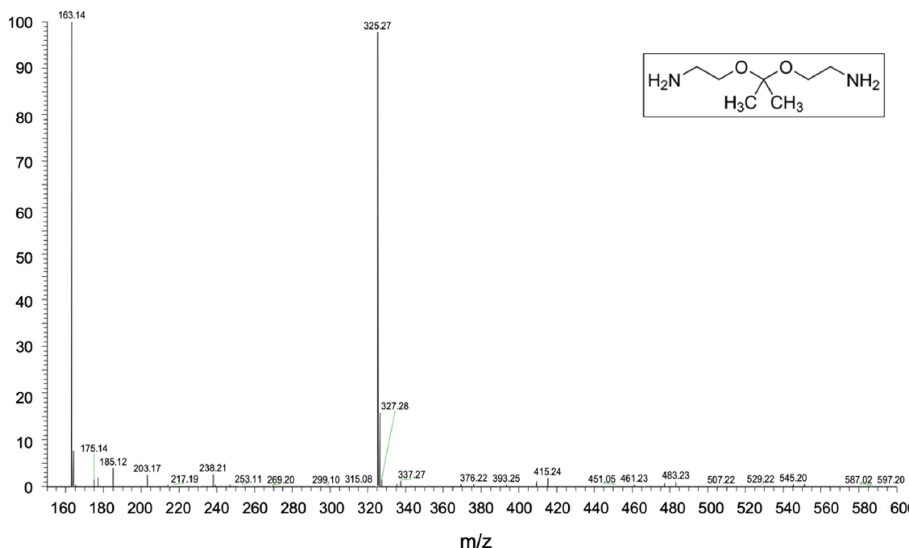
Figure 3. HESI ‐ MS spectra of Recyclamine TM cross ‐ linked agent. Figure 3. HESI-MS spectra of Recyclamine TM cross-linked agent.